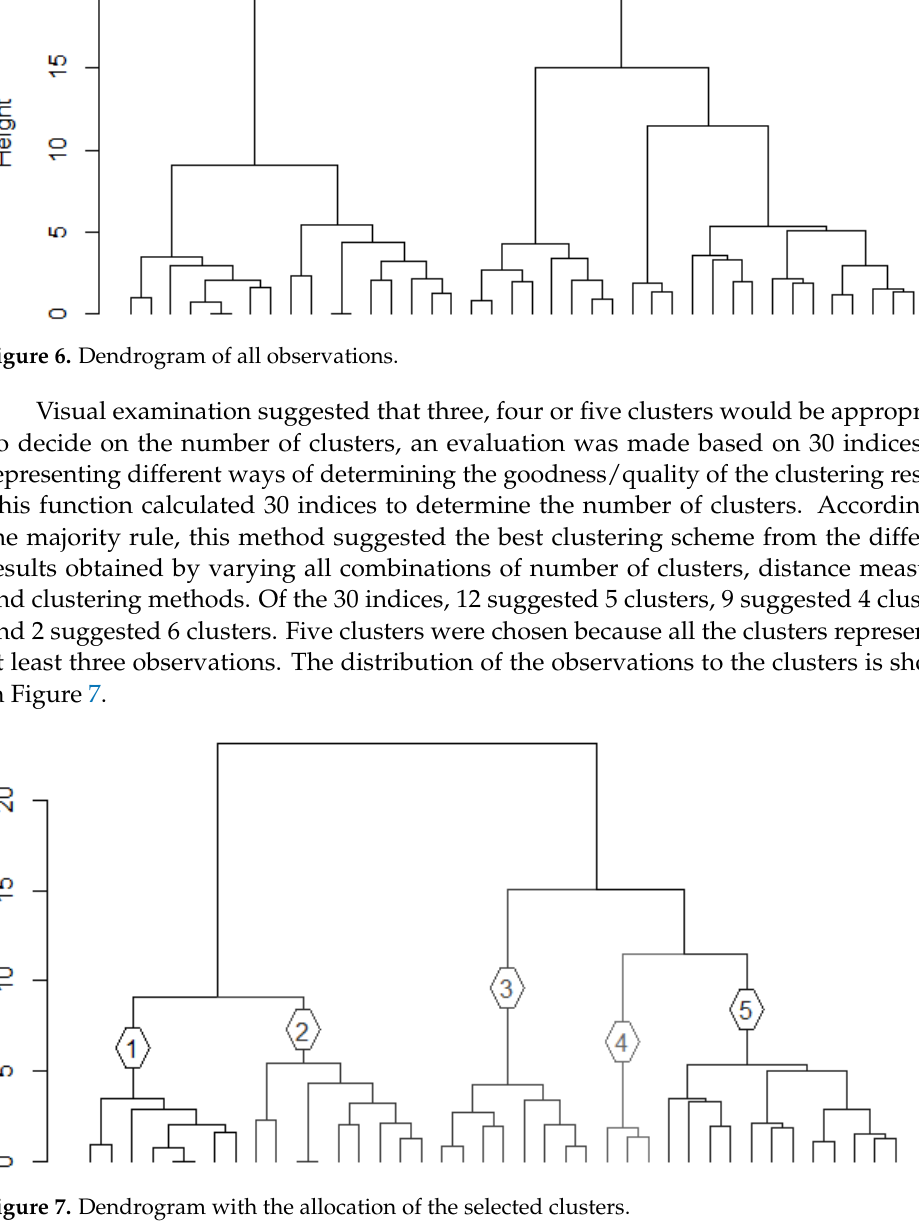
Figure 7. Dendrogram with the allocation of the selected clusters.